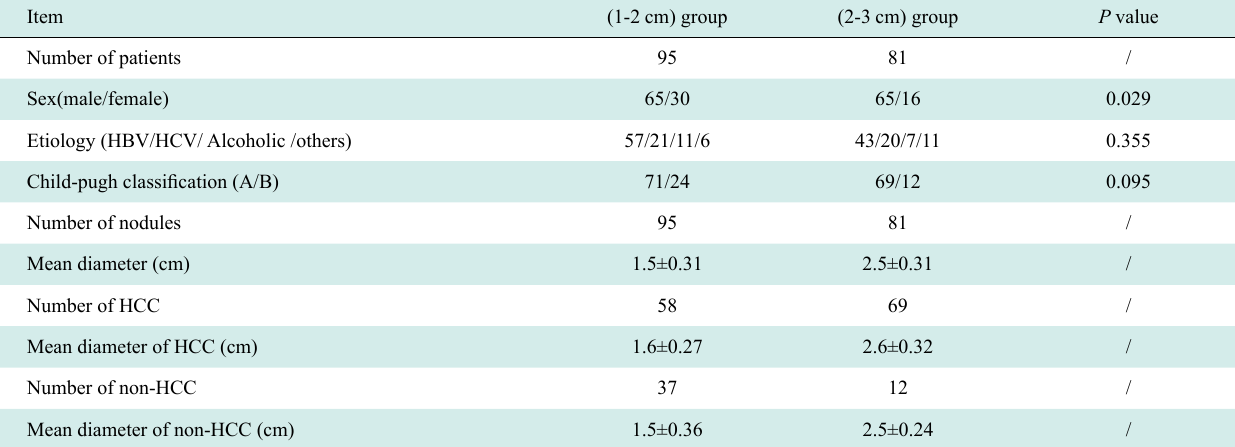
Table 2 Basic clinical characteristic of 176